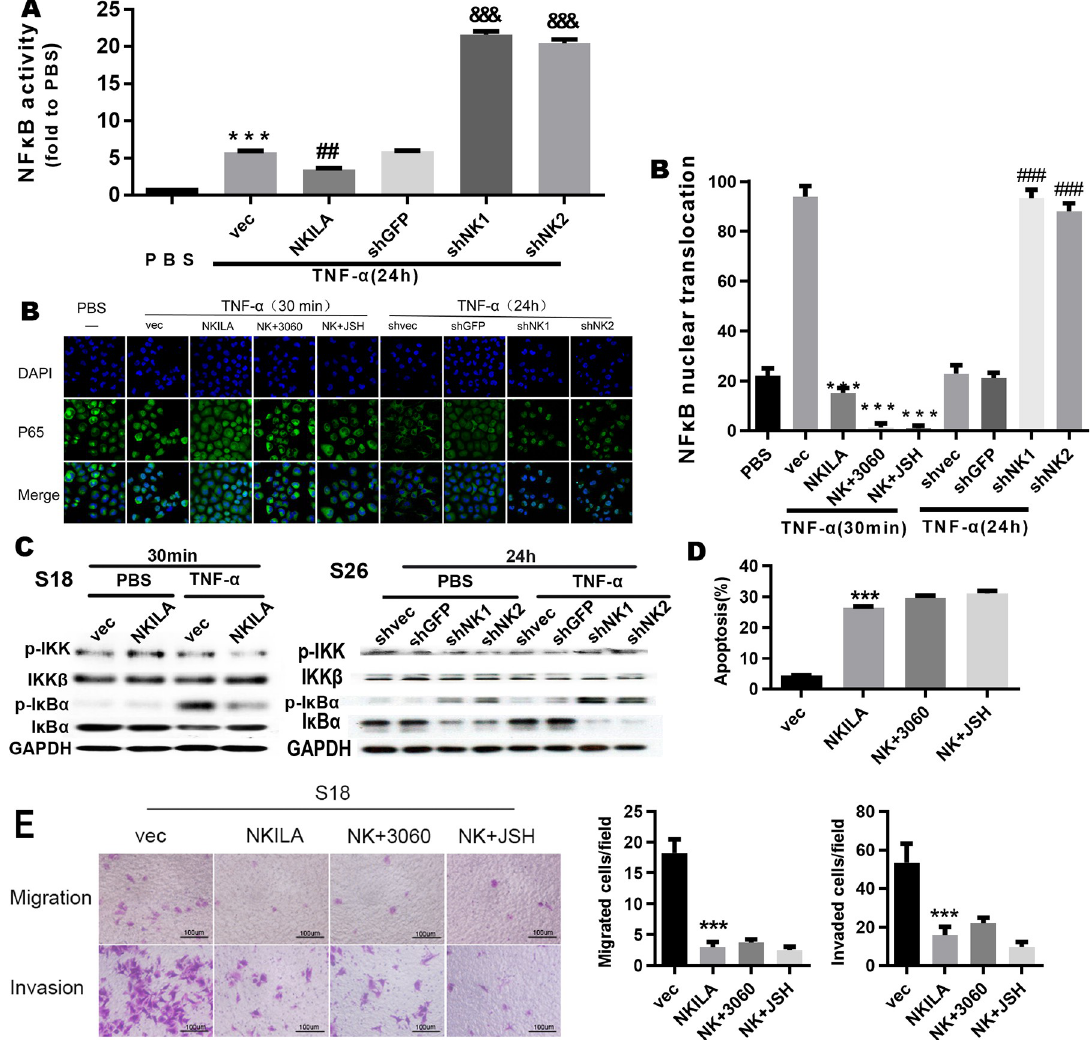
Fig 6. NKILA inhibits the activation of NF- κ B by repressing I κ B phosphorylation. (A) Luciferase reporter assay for detection of NF- κ B activity in S26 cells treated with TNF- α (mean ± SD, n = 3, &&& , P < 0.001 versus shGFP; ## , P < 0.01 versus vec; ��� , P < 0.001 versus PBS). (B) Immunofluorescence confocal microscopy for detection of P65 nuclear translocation in S26 cells with overexpression or depletion of NKILA treated with TNF- α (mean ± SD, n = 3, ��� , p < 0.001 versus vec, ###, P < 0.001 versus shvec). (C) Total and phosphorylated IKK and I κ B α assayed by Western blotting in S26 or S18 cells. (D) Annexin-V/PI staining for detection of apoptosis in S18 cells stably expressing NKILA (48 h after seeding). (mean ± SD, n = 3, ��� , P < 0.001 versus vec; 3060:10 µ M; JSH:5 µ M). (E) Migration and invasion in S18 cells with stably overexpression or depletion of NKILA, assayed by Boyden Chamber assay (16h for migration and 22 h for invasion after seeding, respectively) (mean ± SD, n = 4, ��� , P < 0.001 versus S18